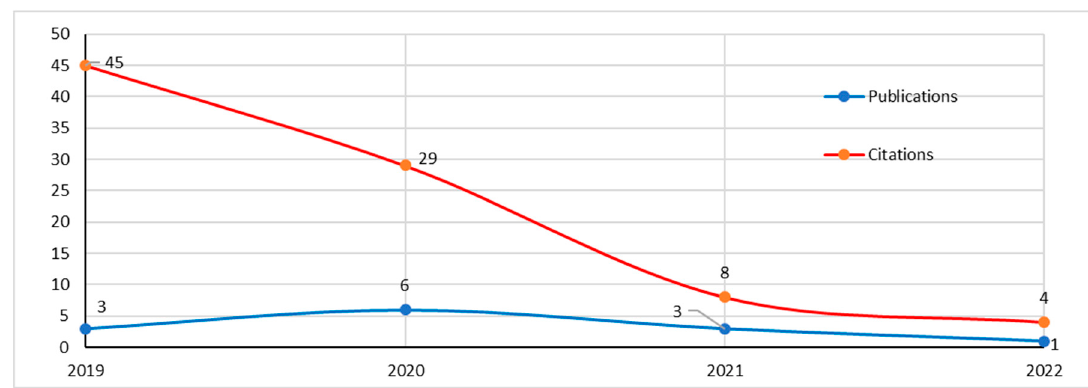
Figure 5. The number of article publications and citations.